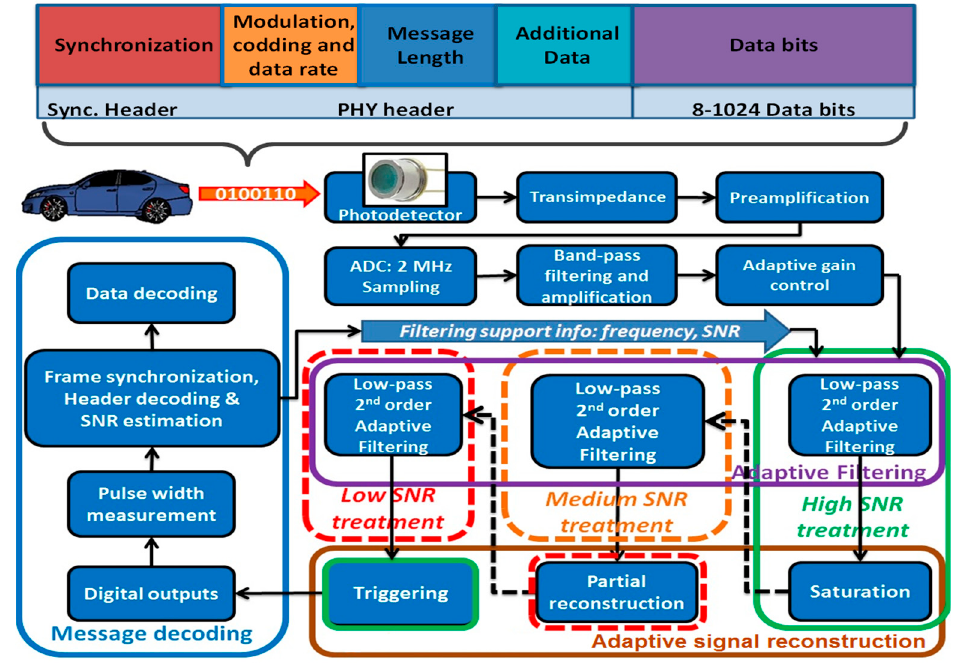
Figure 2. Architecture of the proposed VLC receiver.